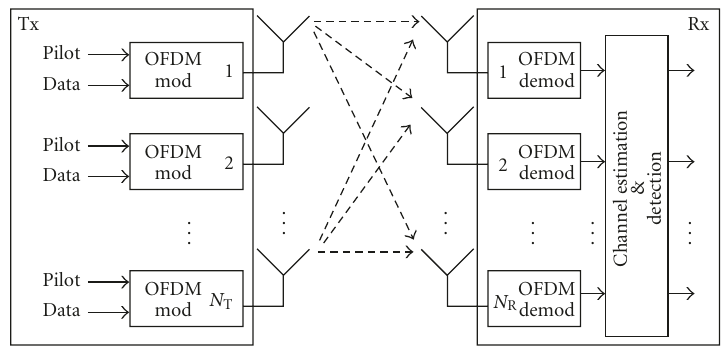
Figure 1: MIMO-OFDM system employing N T transmit and N R receive